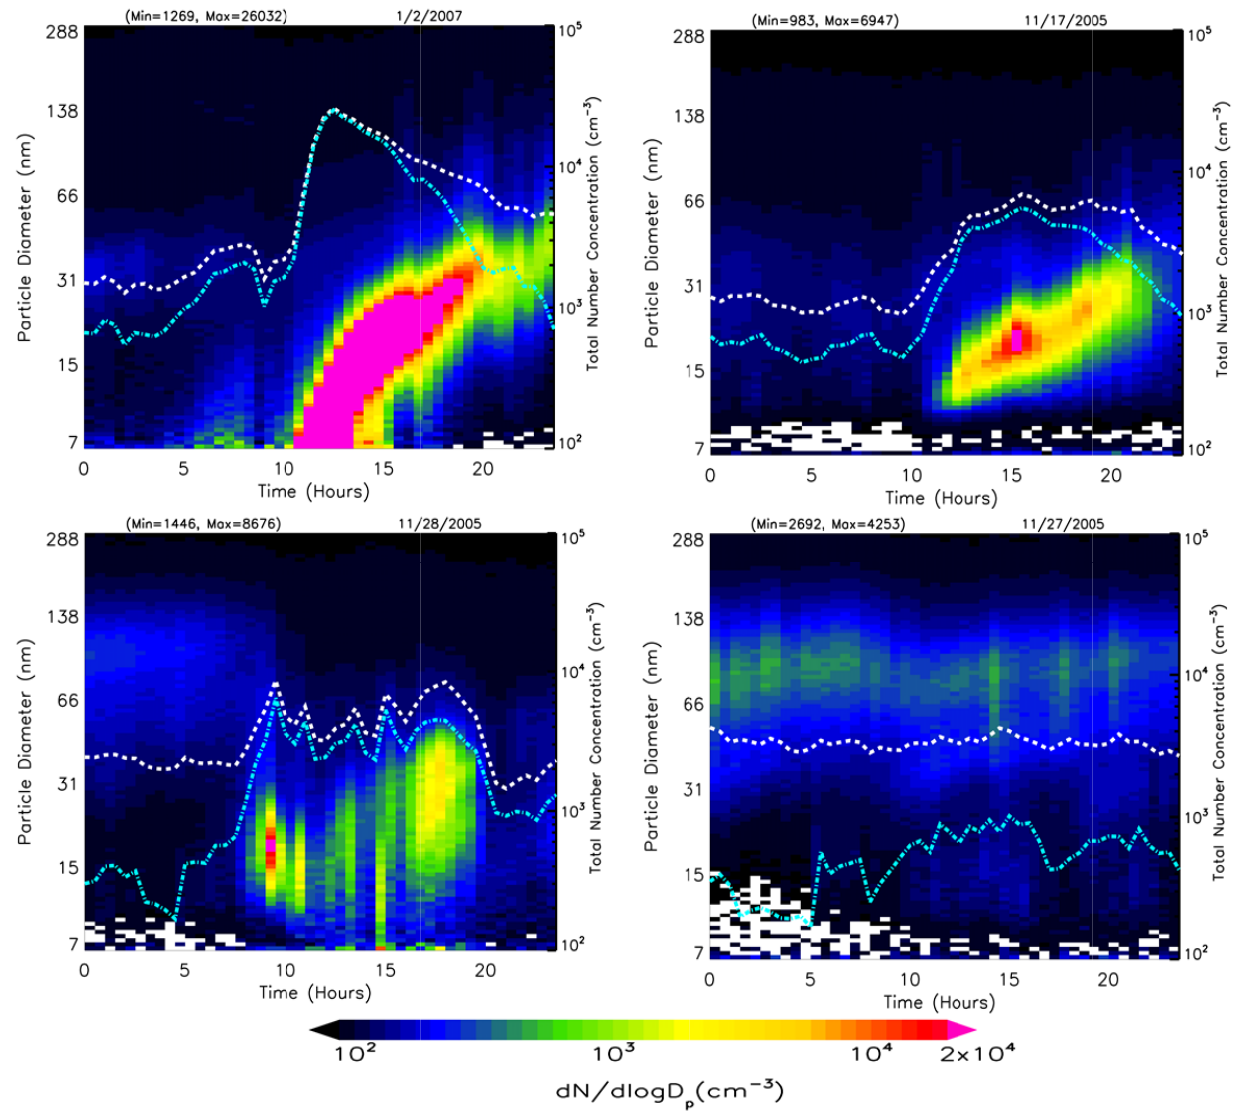
Figure left ), a numbe